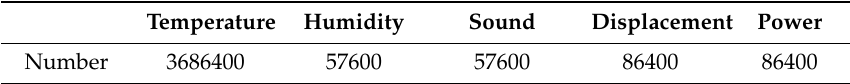
Table 3. Number of sensor data.